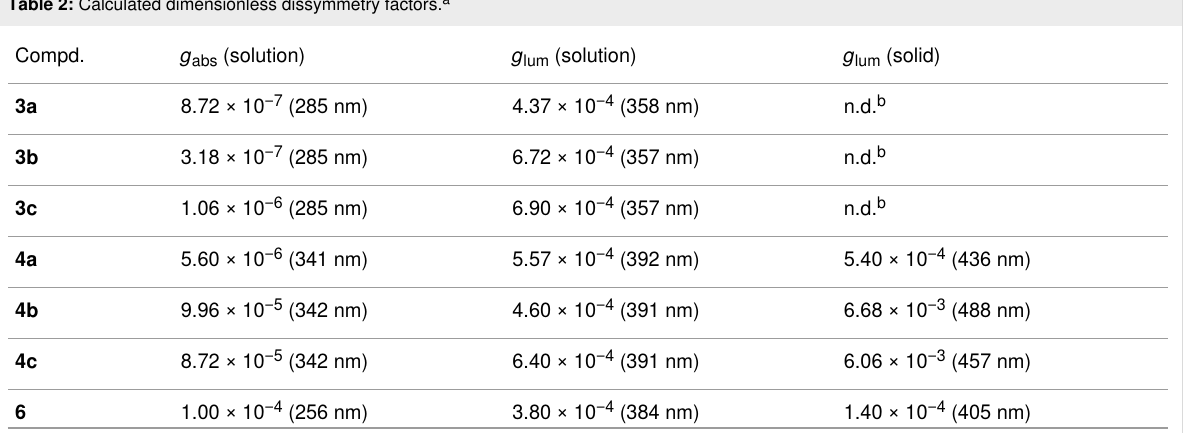
Table 2: Calculated dimensionless dissymmetry factors. a